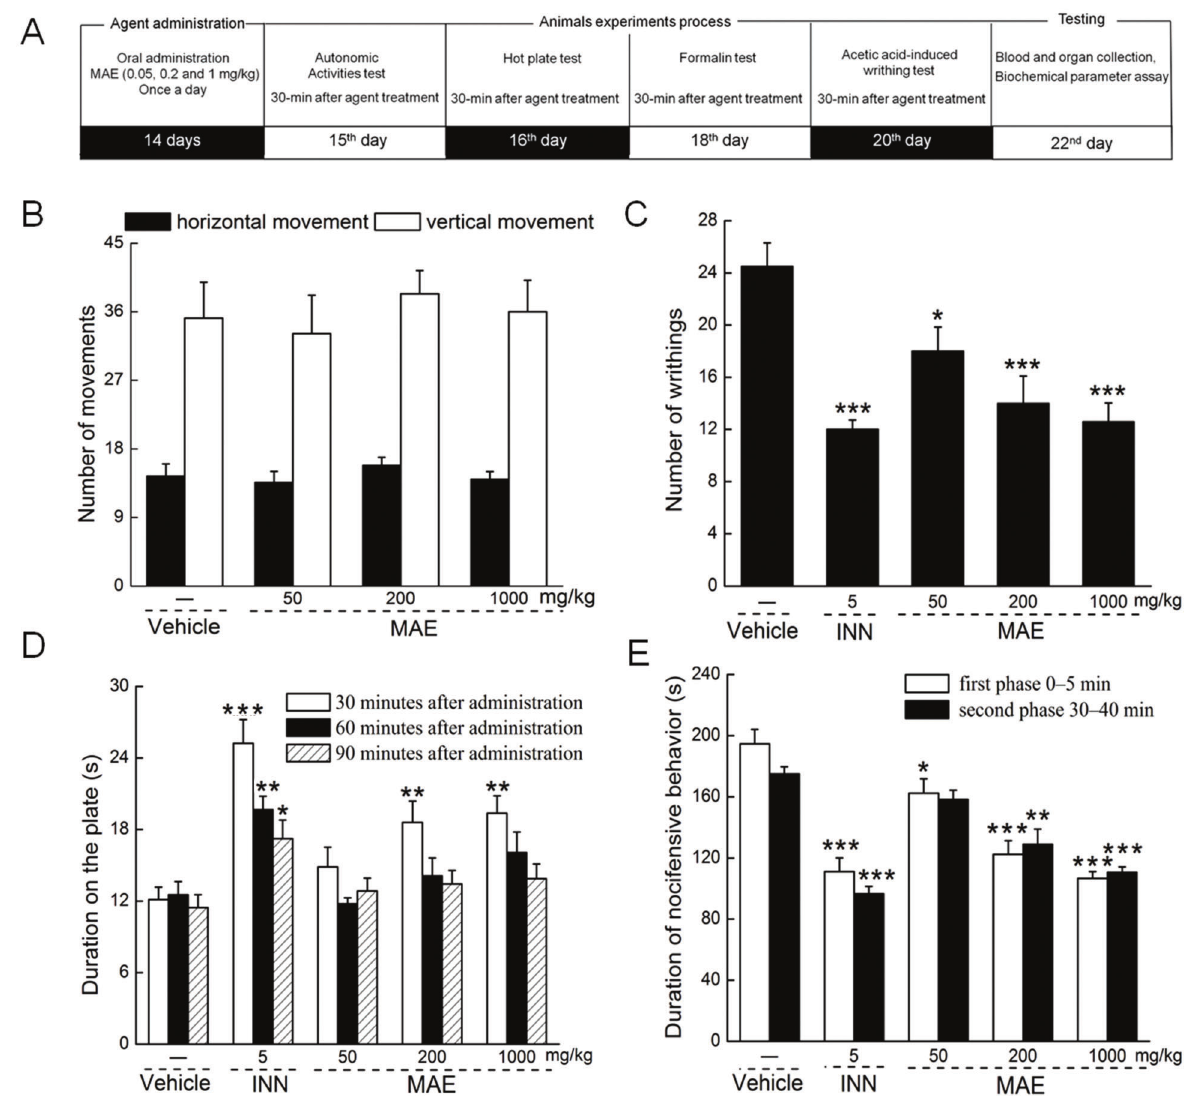
Figure 1. A , Experimental protocol and drug administration. Effects of M. androsaceus extract (MAE) and tramadol (INN) on ( B ) horizontal/vertical movements, ( C ) acetic acid-induced writhing test, ( D ) hot-plate test, and ( E ) formalin test in BALB/c mice. Data are reported as means ± SE (n=10). *P o 0.05, **P o 0.01, and ***P o 0.001 vs vehicle group (one-way ANOVA followed by Dunn ’ s